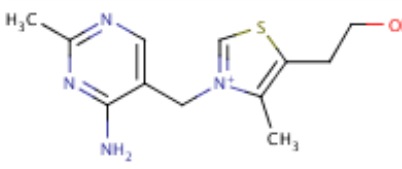
Figure 12. Thiamine structure.